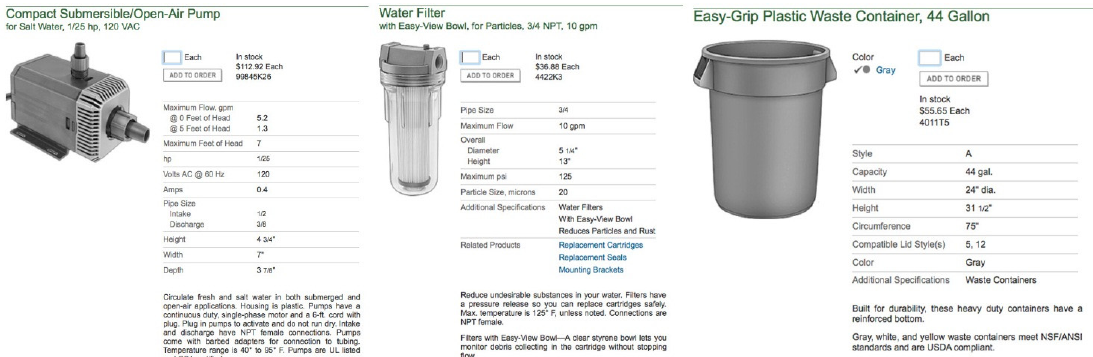
Figure 11. Three essential pieces of equipment for setting up a low-cost cold-filtered seawater system on a research vessel are submersible pumps ( a ), water filter ( b ) and simple water storage containers ( c ). These are installed in a constant temperature van or room on the back deck (Figure 12), which must also be rented or purchased. Images from http://www.mcmaster.com. J. Mar. Sci. Eng. 2015 , 3